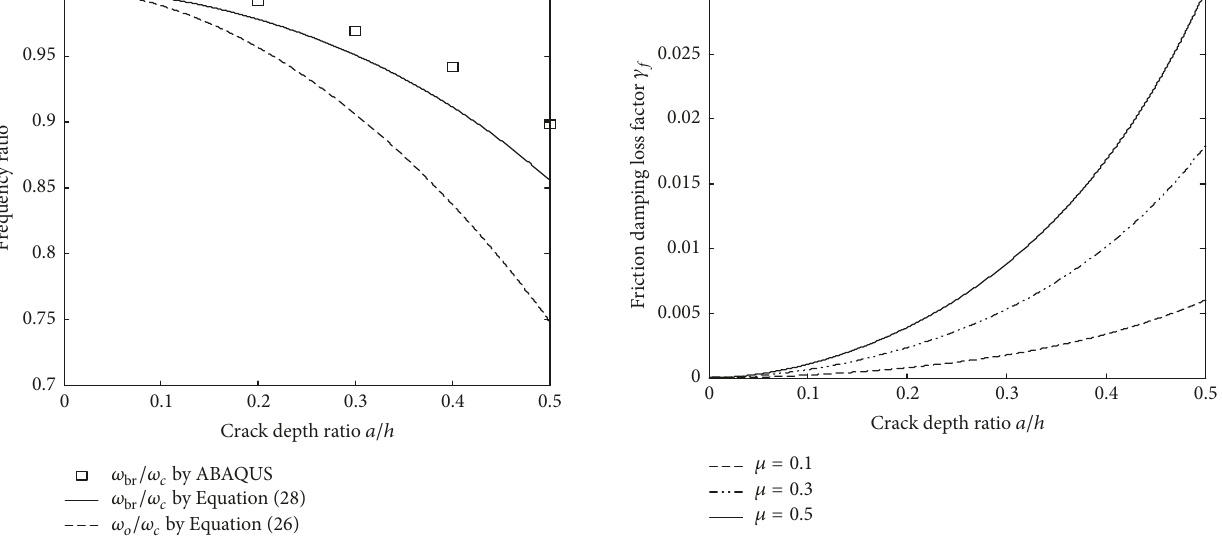
Figure 7: Frequencies change with crack severity. Figure 8: Friction damping loss factor with crack severity change under different friction coefficients.